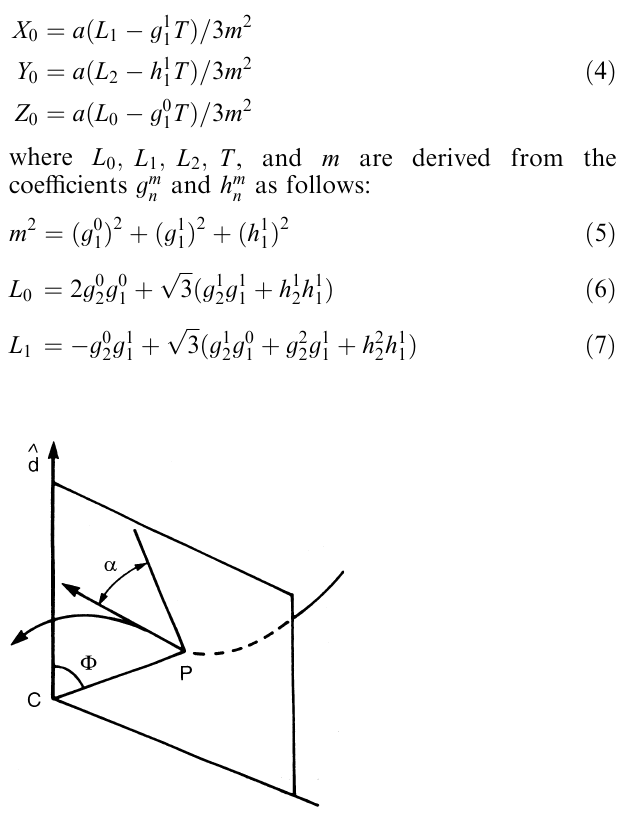
Fig. 1. Definition of (cid:97) as the angle between the plane containing the dipole and the point of incidence P , and the particle trajectory at